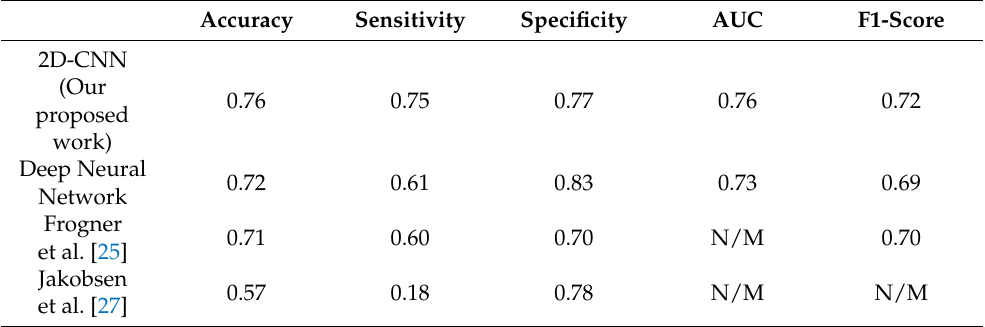
Table 2. Results obtained from proposed work from past investigations that also use convolutional neural networks to detect depression. N/M: the research does not mention the result